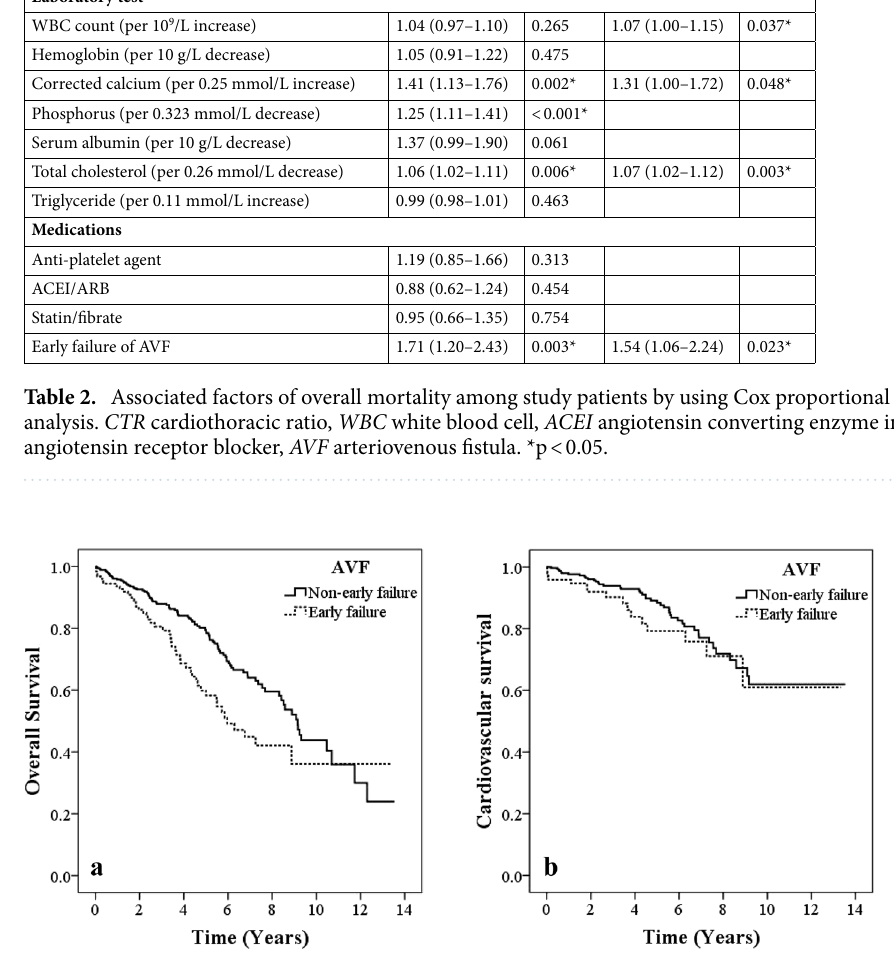
Figure 1. ( a ) Kaplan–Meier analyses of overall survival in patients with early failure and non-early failure of AVF. Log-rank p = 0.002. ( b ) Kaplan–Meier analyses of cardiovascular survival in patients with early failure and non-early failure of AVF. Log-rank p =